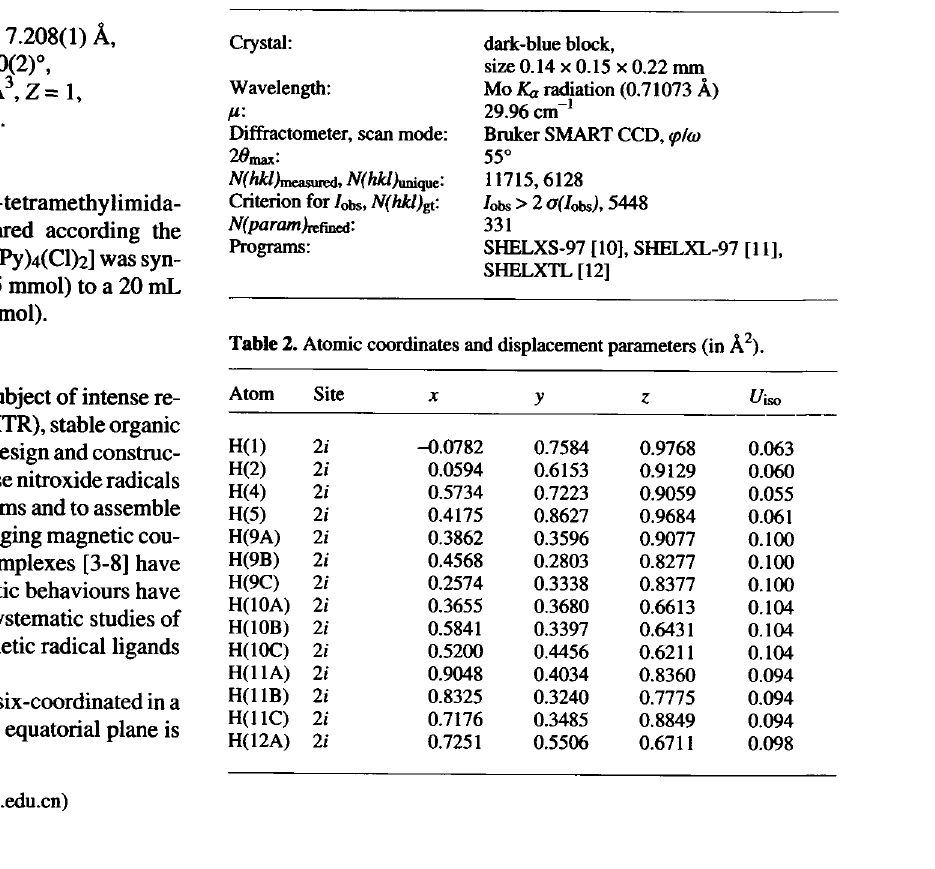
Table 2. Atomic coordinates and displacement parameters (in À 2